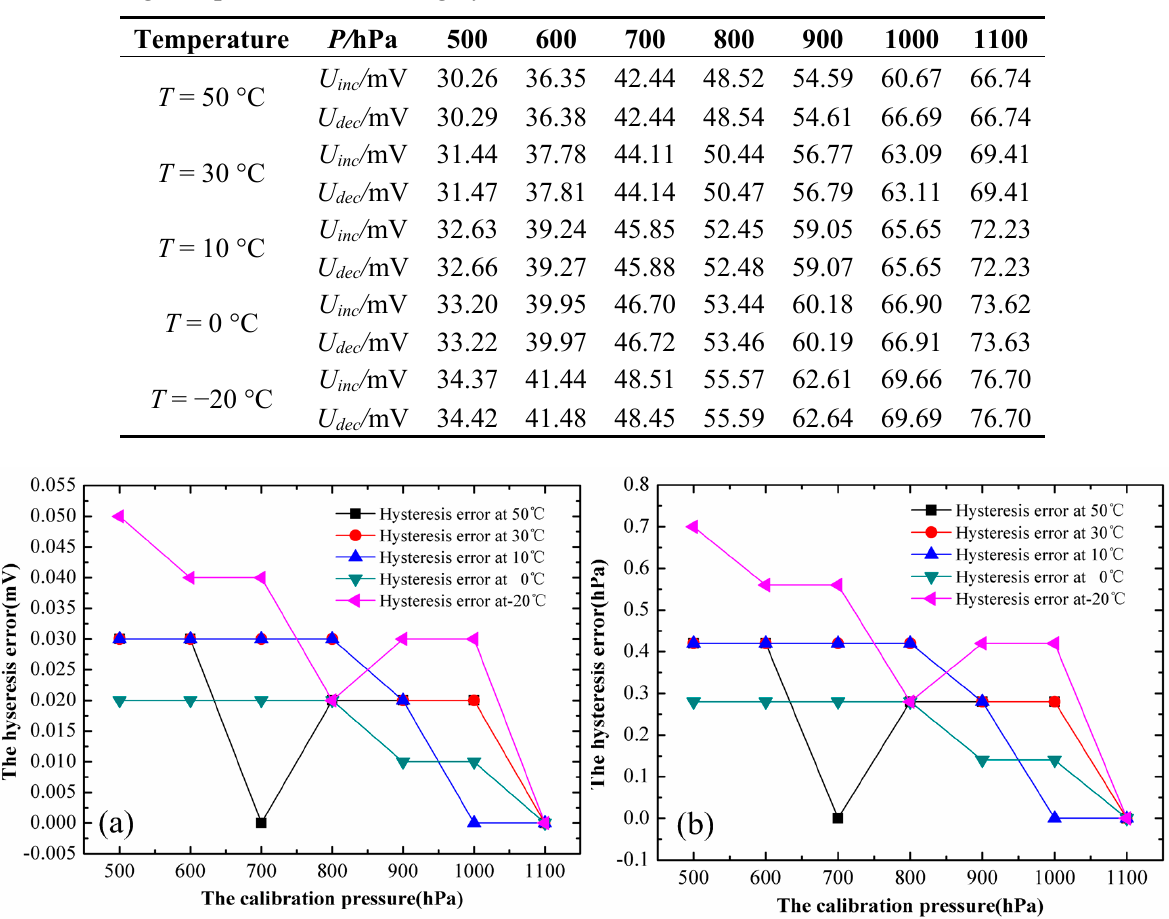
Table 3. The output voltage of the sensor array without compensation during the pressure increasing and pressure decreasing cycle at 50 °C, 30 °C, 10 °C, 0 °C, and − 20 °C.